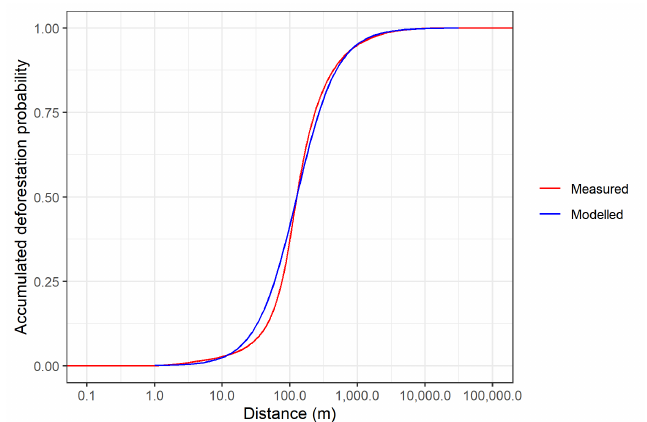
Figure 5. Accumulated probability of deforestation on the Brazilian Amazon, as a function of the distance to previous deforestations. The modelled distribution is a logistic distribution of log 10 ( distance ) .